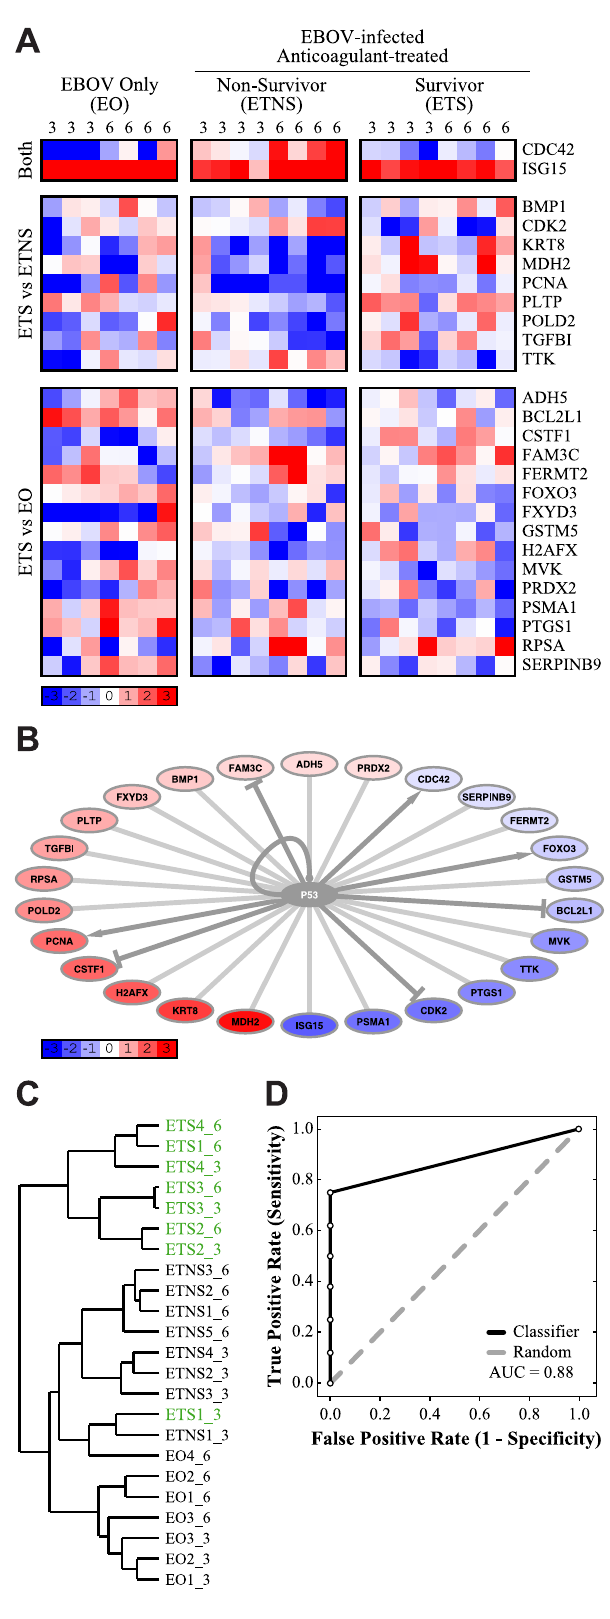
Figure 5. Tumor protein 53 (p53) regulates transcription of some survival-associated genes. ( A ) A heatmap depicting the gene expression values of 26 probes (26 genes) which are